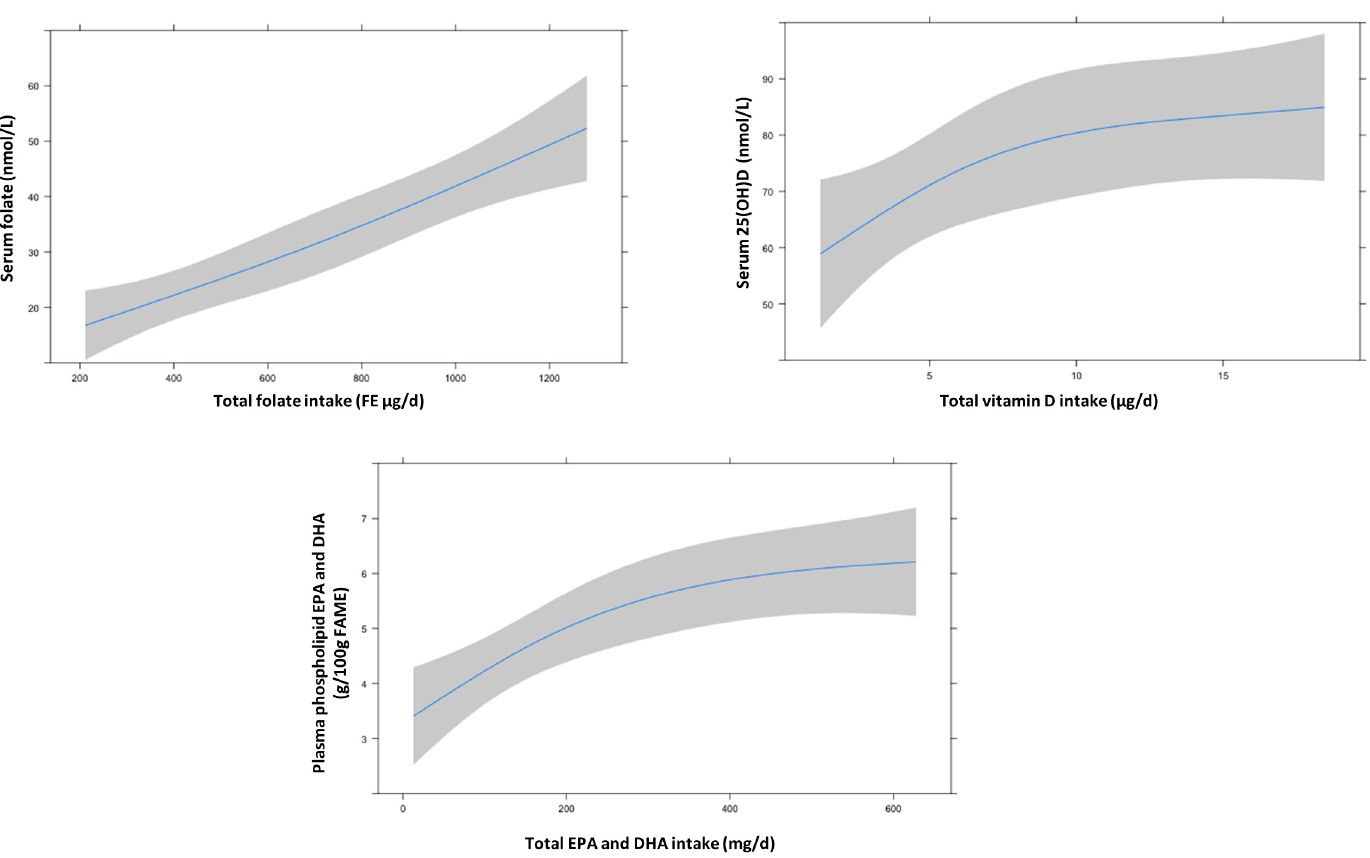
Figure 1. Associations between total intake and blood levels of folate, vitamin D, and EPA+DHA, obtained by restricted cubic spline regressions with three knots located at 1st, 5th, and 9th decile. Solid lines represent the estimated dose-response curves, and the shaded areas represent the 95% confidence intervals. Intake-status association of folate was adjusted for season of blood sampling, energy intake (kJ) and intake of vitamin B6 (mg/day) and B12 ( µ g/day) ( p for non-linearity = 0.69); intake-status association of vitamin D was adjusted for season of blood sampling, education level (low/intermediate/high), BMI (kg/m 2 ) and energy intake (kJ) ( p for non-linearity = 0.17); intake-status association of EPA+DHA was adjusted for season of blood sampling, education level (low/intermediate/high), BMI (kg/m 2 ) and energy intake (kJ) ( p for non-linearity = 0.05).